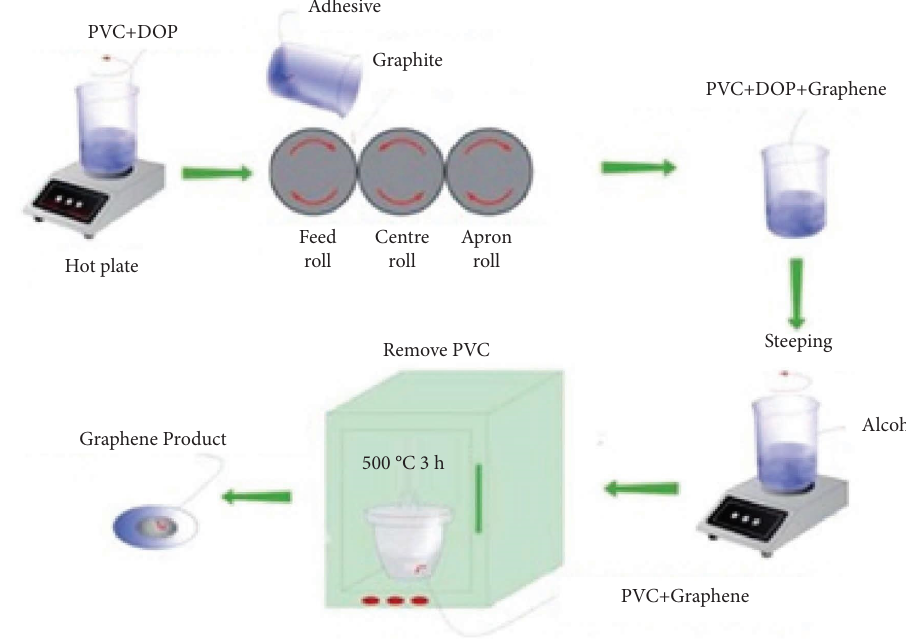
Figure 7: Tree-roll milling [29].